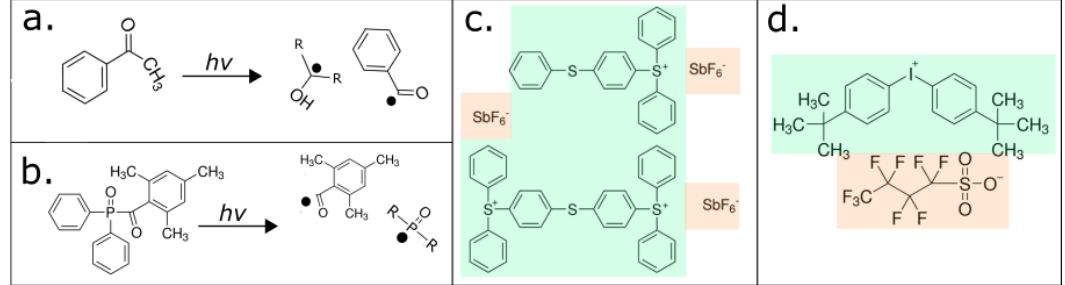
Figure 2. The two photoinitiator (PI) mechanisms are radical ( a , b ) and cationic ( c , d ). In the radical system, absorption of light ( hv ) produces a free radical by homolytic cleavage, propagating polymerization, for example, as in (a) hydroxyacetophenone and (b) phosphine-oxide, where R represents a methyl group in (a) and a phenyl ring in (b). In the cationic PI system, in PIs such as (c) triarylsulfonium hexafluoroantimonate salts and (d) bis(4-tert-butylphenyl)iodonium perfluoro-1-butanesulfonate, light is absorbed causing heterolytic and homolytic cleavage that forms a cationic portion (labeled in green) and anionic portion (labeled in pink). The generated molecules are reactive with monomers, forming an acid and free radicals, propagating polymerization (open source image adapted from